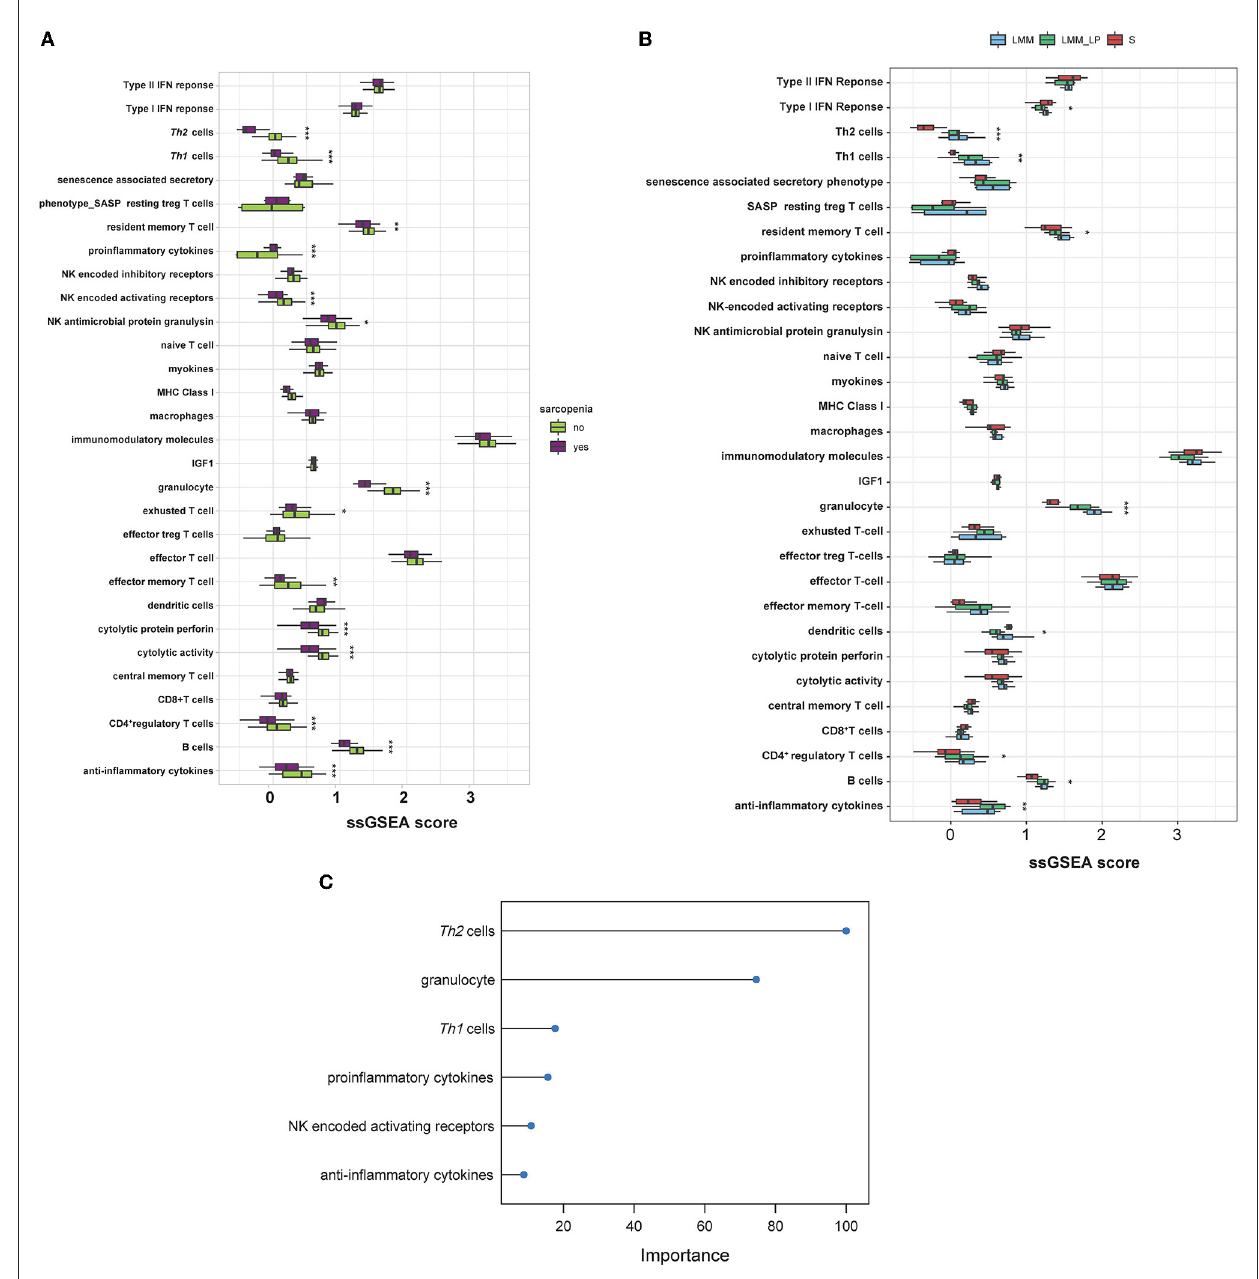
FIGURE4 Immunological landscape of the S, LMM, and LMM_LP groups. (A) Comparison of 30 immune signature expression levels between sarcopenia and healthy controls ( t -test, p -values are shown. * p < 0.5, ** p < 0.01, and *** p < 0.00). (B) Comparison of 30 immune signature expression levels between the S, LMM, and LMM_LP groups (ANOVA test, p -values are shown. * p < 0.5, ** p < 0.01, and *** p < 0.00). (C) The elastic regression model discriminates sarcopenia from a healthy control based on 30 immune signature expression profiles. Model importance was identified as regression